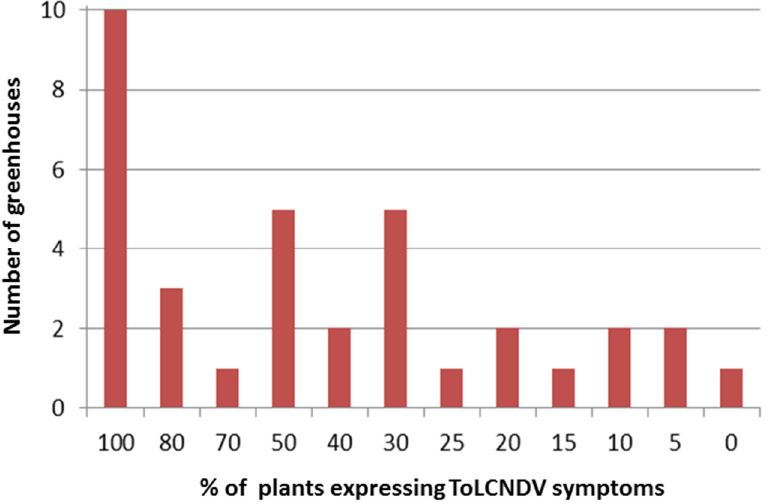
Figure 2. Greenhouse frequency distribution of ToLCNDV-symptomatic plants.